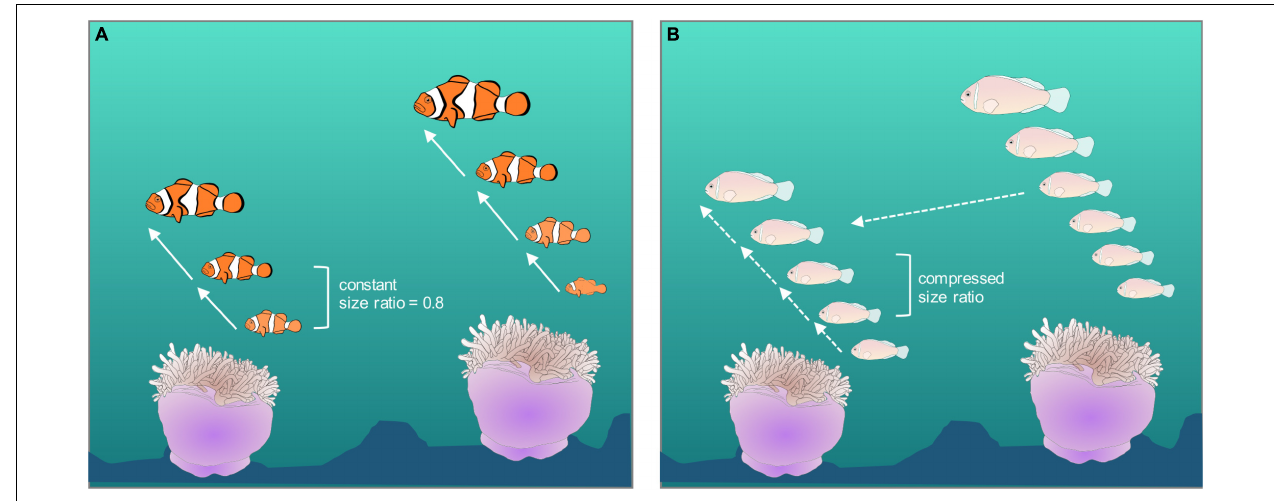
FIGURE 6 | Possible relationship between ecological constraints, territory inheritance, and social organization and behaviors; (A) schematic of social organization in Amphiprion percula , where ecological constraints are high, movement between anemones does not occur, the probability of territory inheritance is high and the size hierarchy is strict with exact ratios; (B) social organization of Amphiprion perideraion where ecological constraints are relaxed, movement between anemones does occur, groups are less stable and the size hierarchy is more